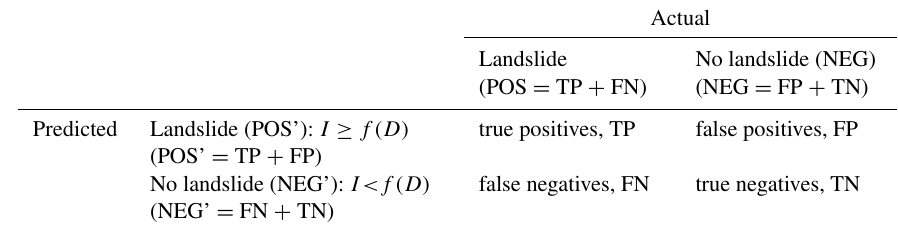
Table 5. Confusion matrix for evaluation of landslide-triggering thresholds (assumed here to be of the ID type: I = f (D)) .